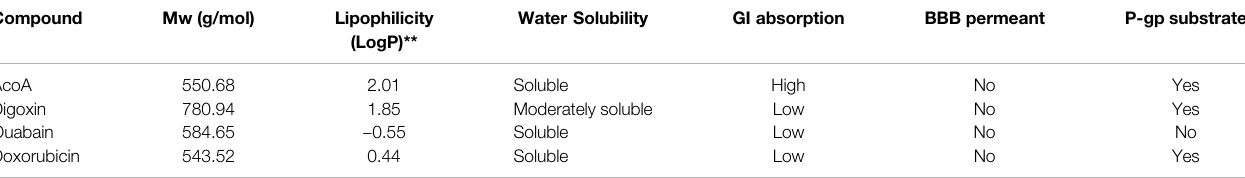
TABLE 1 | Predicted physicochemical and pharmacokinetic properties of the investigated cardenolide glycosides and doxorubicin according to SwissADME*. Compound Mw (g/mol) Lipophilicity Water Solubility GI absorption BBB permeant P-gp substrate (LogP)** AcoA 550.68 2.01 Soluble Moderately